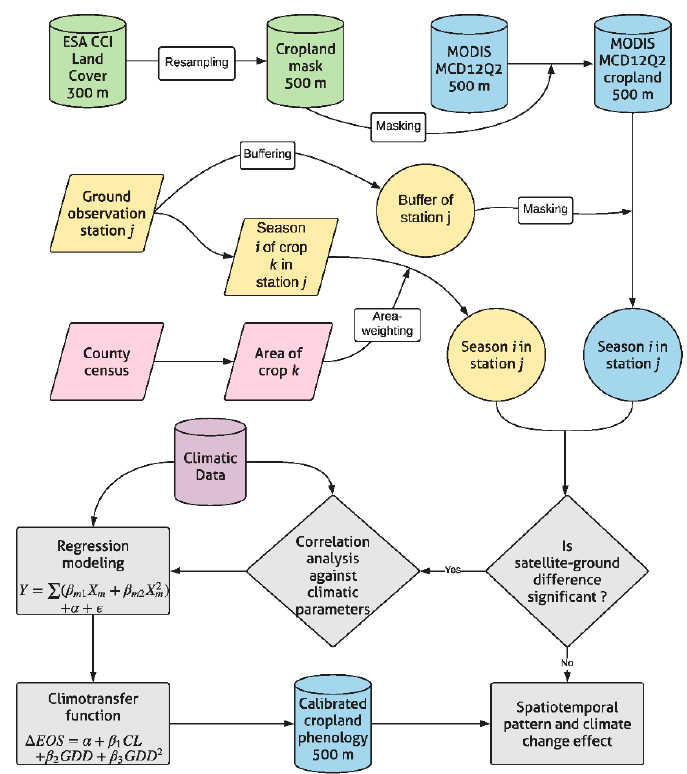
Figure 3. The flowchart of the methodological approach.